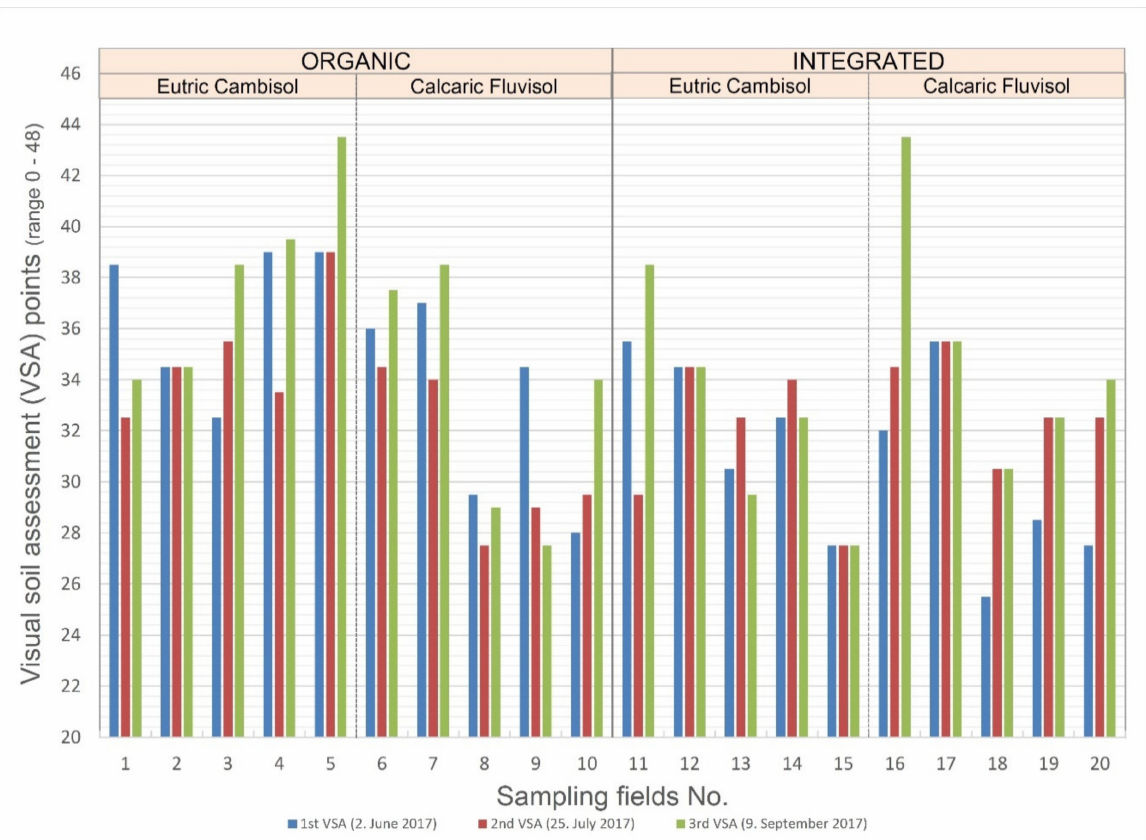
Figure 2. The visual soil assessment (VSA) soil quality index points by individual experimental fields and assessment